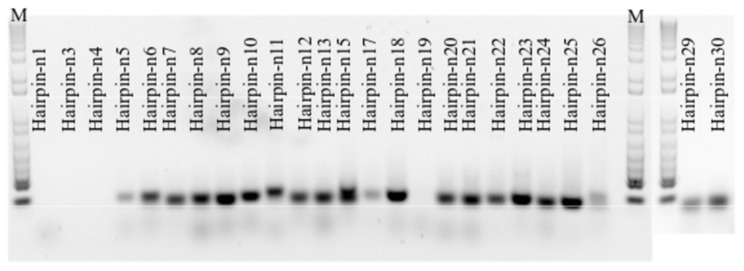
RT-PCR of Atlantic halibut novel hairpins.Small RNA fraction (<200 bp) was used to amplify the predicted precursor miRNAs. The name of each hairpin is assigned from n1 to n25. M stands for 1 Kb DNA size marker.